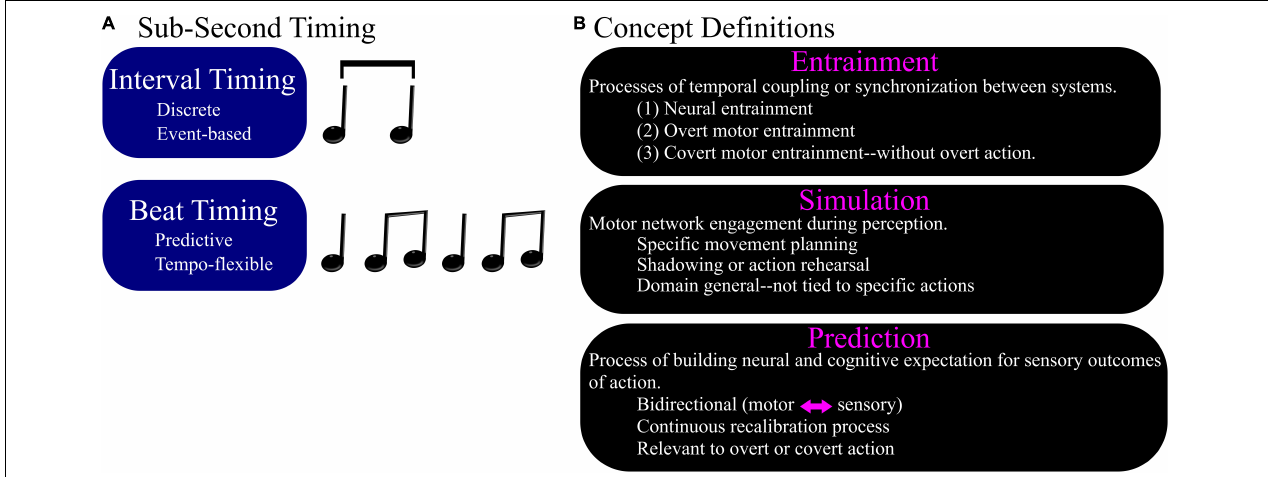
FIGURE 1 | Timing for musical rhythm perception. (A) Sub-second timing can be discrete, such as for perception of interval durations, or can be continuous, as in the case of musical beat perception. Musical timing co-opts sensorimotor systems for accurate continuous timing perception. Evidence from overt motor synchronization tasks supports that musical timing is predictive and tempo-flexible. (B) Definition of concepts in the context of sensorimotor neuroscience: entrainment, simulation, prediction.